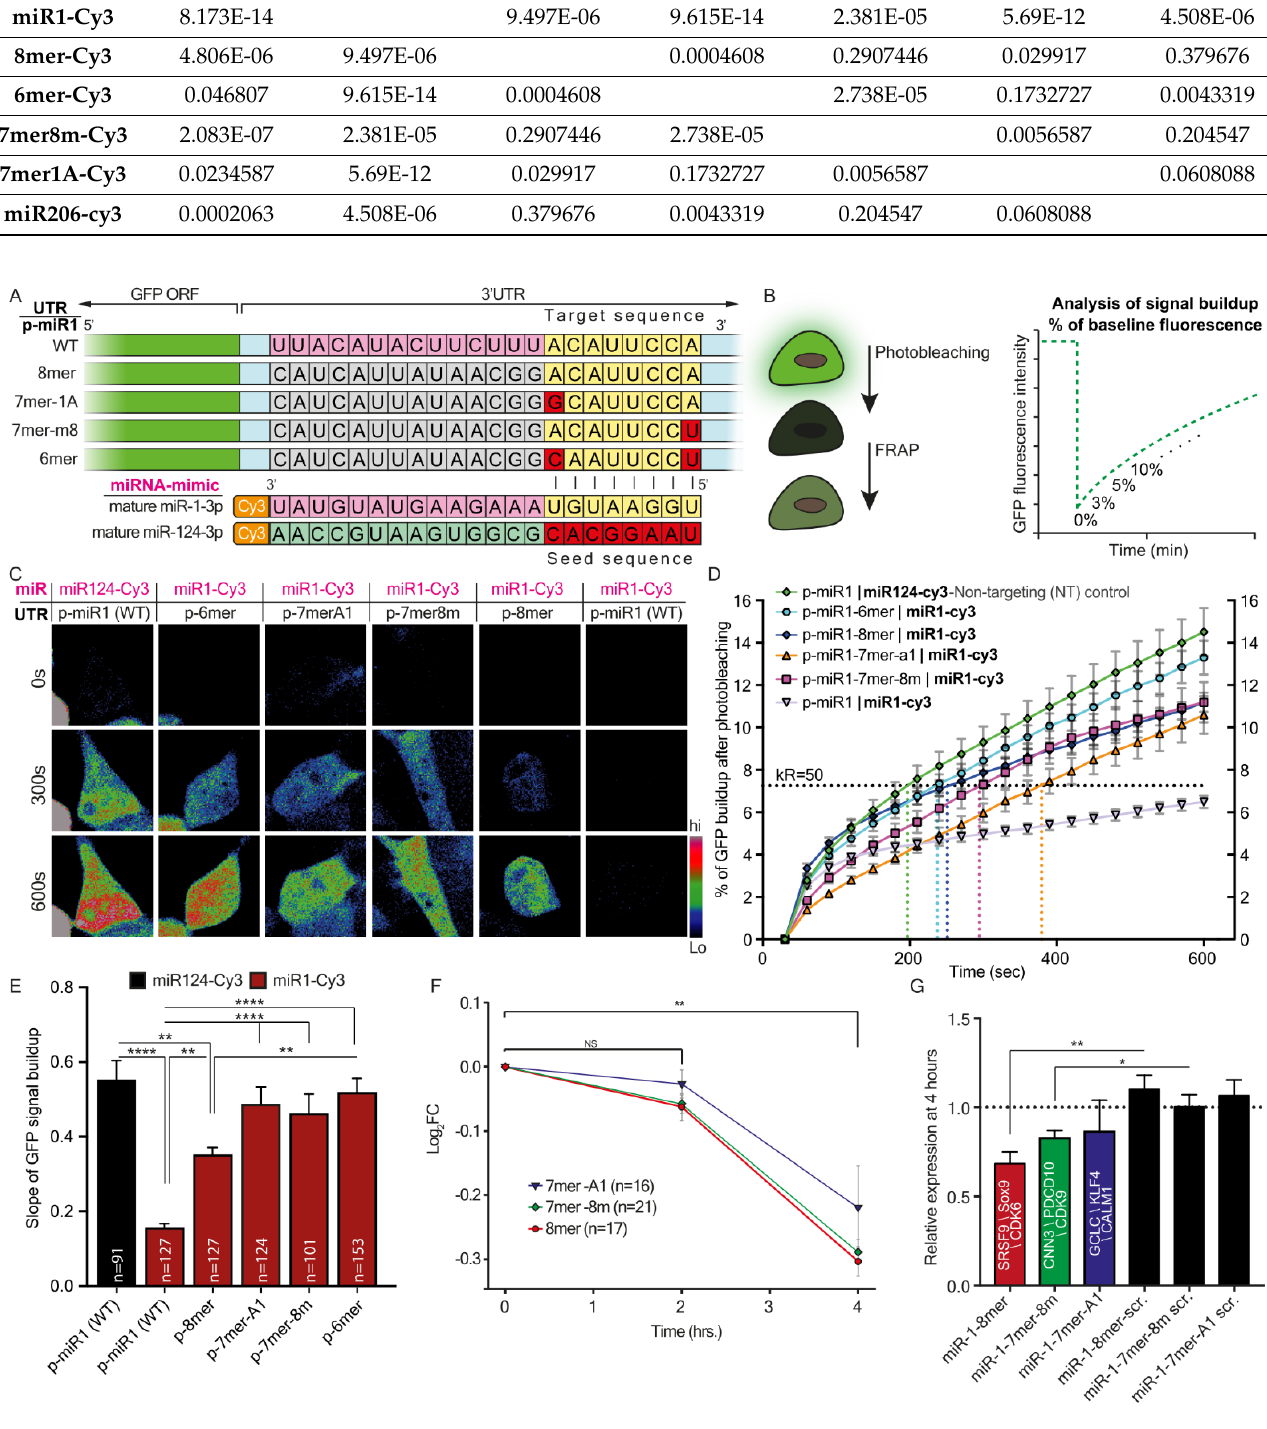
Figure 1. Target GFP downregulation caused by a number of miR-1-3p canonical sites located on the target 3 ’ UTR. ( A ) Schematic illustration of the experimental setup. Five dGFP expression plas- mids containing miR-1-3p canonical sites in the 3′ UTR of dGFP were each co-transfected together with mature Cy3-miR-1, or with mature Cy3-miR-124 as a control, into 293T cells. Green indicates the GFP coding sequence (CDS); light blue indicates the 3′ UTR of dGFP; nucleotides labeled in pink indicate nucleotides in full complementation to mature miRNA; nucleotides labeled in grey indicate random nucleotides not complementing the full sequence of mature miR-1; nucleotides labeled in yellow and red indicate nucleotides in the miRNA target sequence that are complementary and non- complementary, respectively, to the seed sequence; nucleotides labeled in light-green indicate the sequence differences in the miR-124 sequence. ( B ) Schematic illustration of the dGFP Fluorescent Recovery After Photobleaching (FRAP) assay for measuring rates of protein synthesis. At 24-hours after transfection, GFP fluorescence in cells is photobleached; the build-up of the fluorescent signal is then recorded for 10 minutes. Time-lapse movies are analyzed to calculate the percent of fluores- cent signal build-up compared to the baseline signal after photobleaching. ( C ) Representative im- ages of dGFP in 293T cells carrying miR-1-3p canonical sites in 3′ UTR co-transfected with mature miR-1-3p. Images show three time points for each cell: 0, 5, and 10 minutes after photobleaching. ( D ) A graph showing the cumulative percent of fluorescence of dGFP during the 10 minutes follow- ing photobleaching. The horizontal K R50 line indicates the Y value at which 50% of the maximal re- covery is achieved in the non-targeting control (miR-124-cy3). K R50 is used as a reference point for